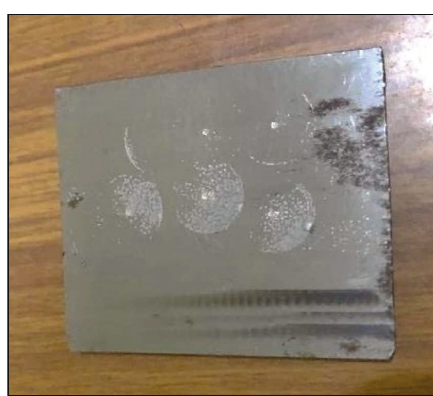
Figure 6: Machined sample of mild steel.